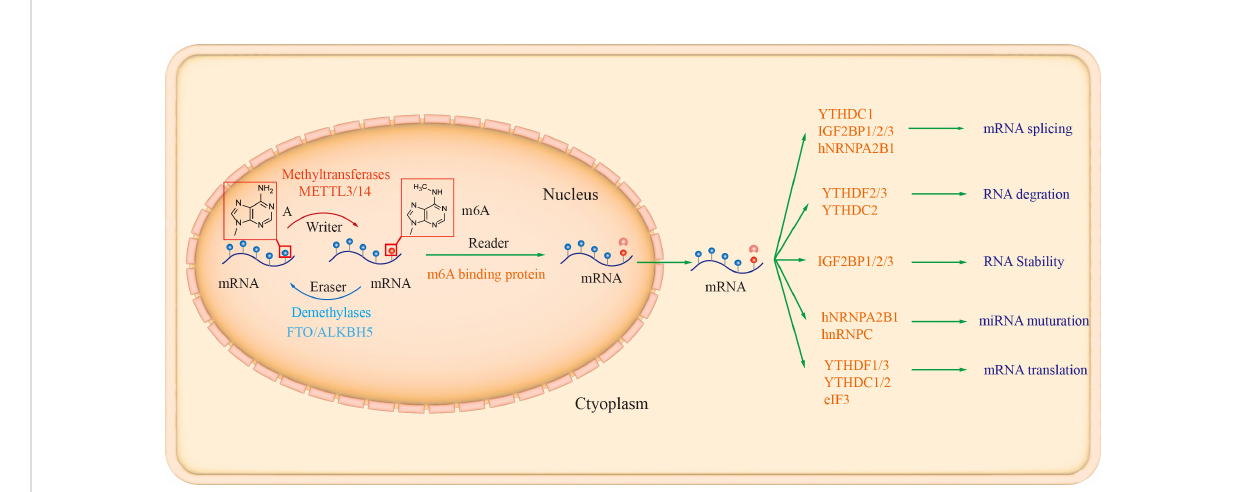
FIGURE 1 The biology functions of m 6 A enzymes. There are three different types of m6A enzymes, namely “ Writer ” (such as METTL3, METTL14, WTAP, and KIAA1429), “ Eraser ” (ALKBH5 and FTO), and “ Reader ” (YTHDF1/2/3, YTHDC1/2, YTHDC2 HNRNPA2B1, HNRNPC and IGF2BP1/2/3, which involved in mRNA degradation, translation, stability, and non-coding RNA processing (Tang et al., 2021; Deng et al.,